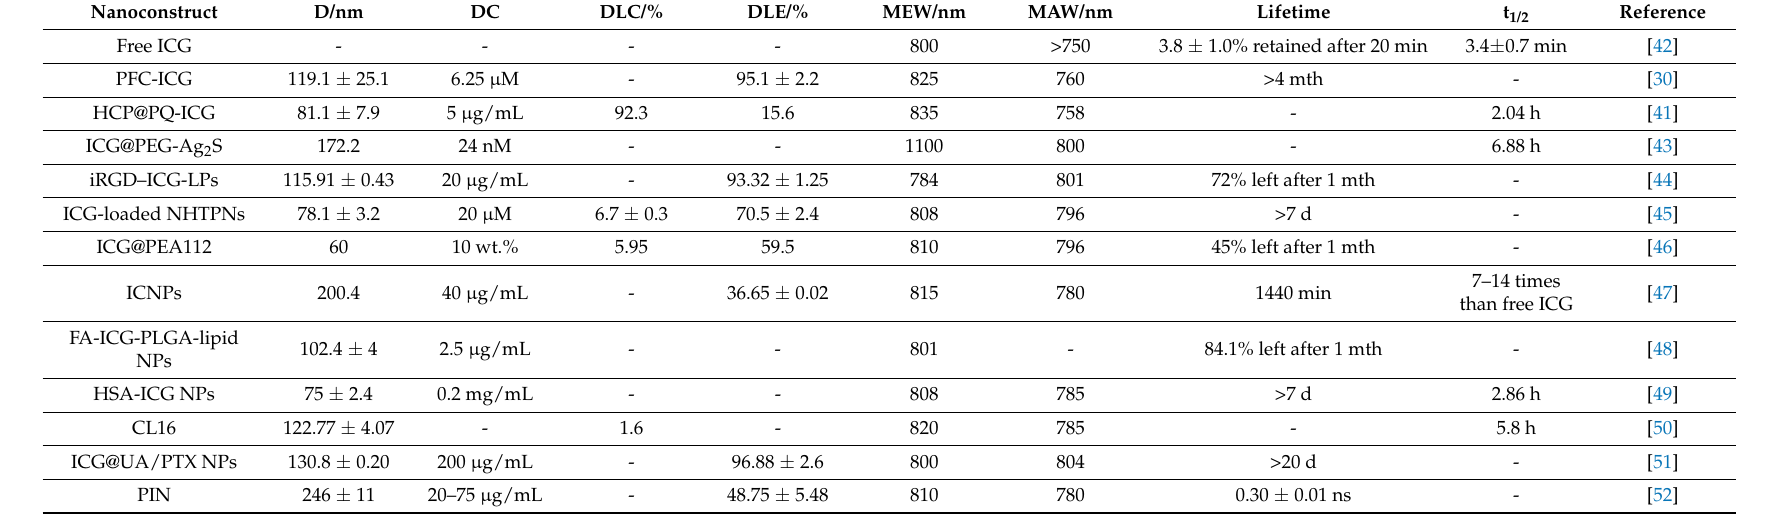
Table 1. Summary presenting the optical properties and biological half-life of various ICG-encapsulated polymeric nanocomposites in comparison to free